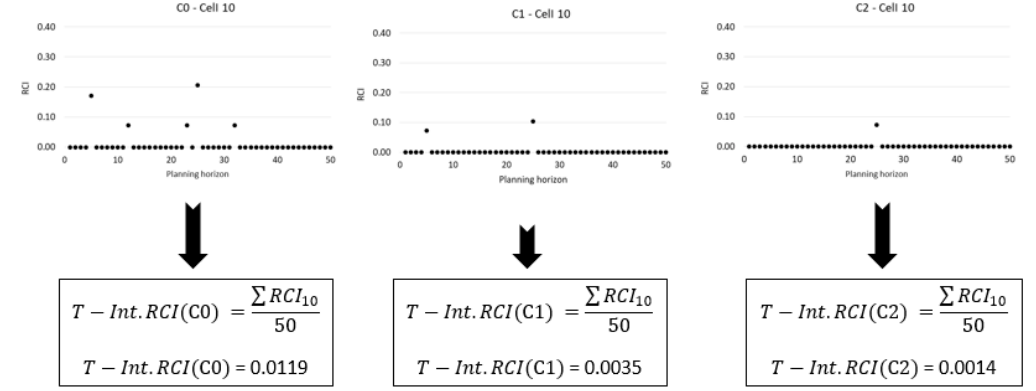
Figure 13. Example of RCI results in Cell 10 scenarios C0, C1 and C2.